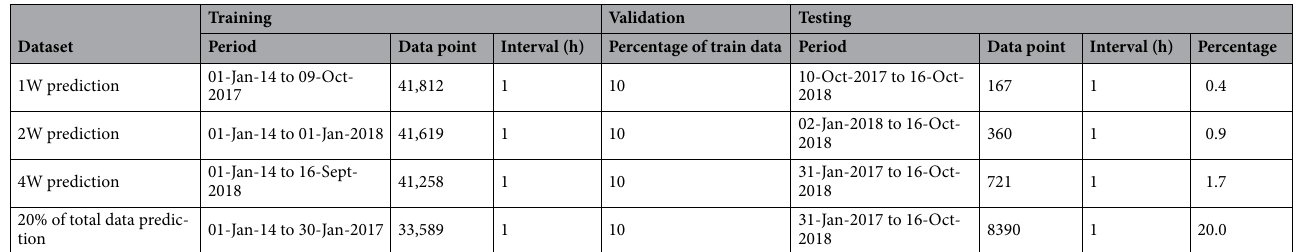
Table 1. Data segregation in terms of training, validation and testing for the hourly streamflow ( Q , m 3 s −1 ) prediction at Brisbane River and Teewah